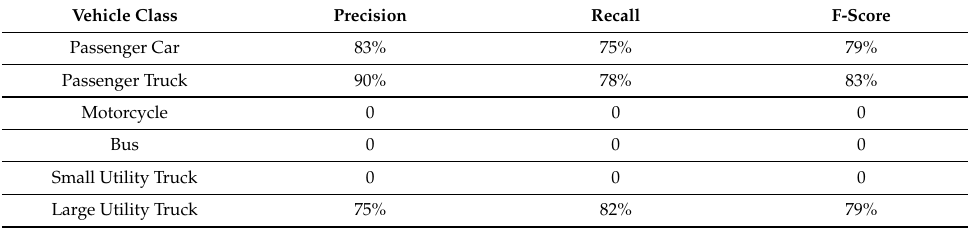
Table 15. Different evaluation metrics for the detected classes within Video